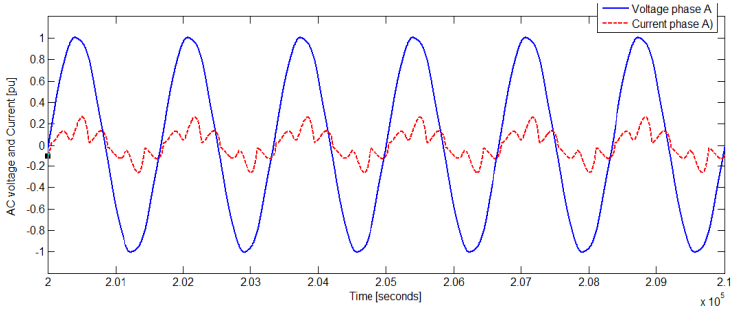
Figure 8. AC side voltage and current. Table 1. System parameters.